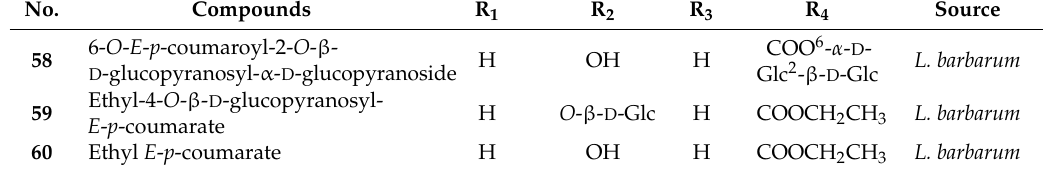
Figure 4. Chemical structures of compounds 52 – 57 , 61 . Table 5. Chemical structures of compounds 58 – 60 .